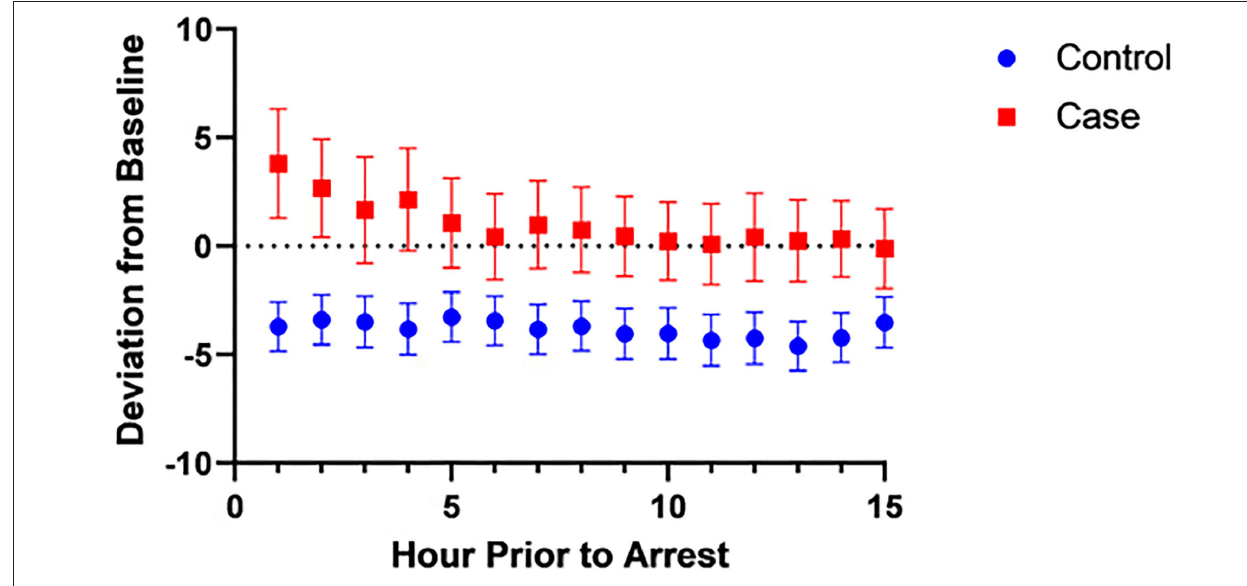
FIGURE 4 | Changes in heart rate over time.